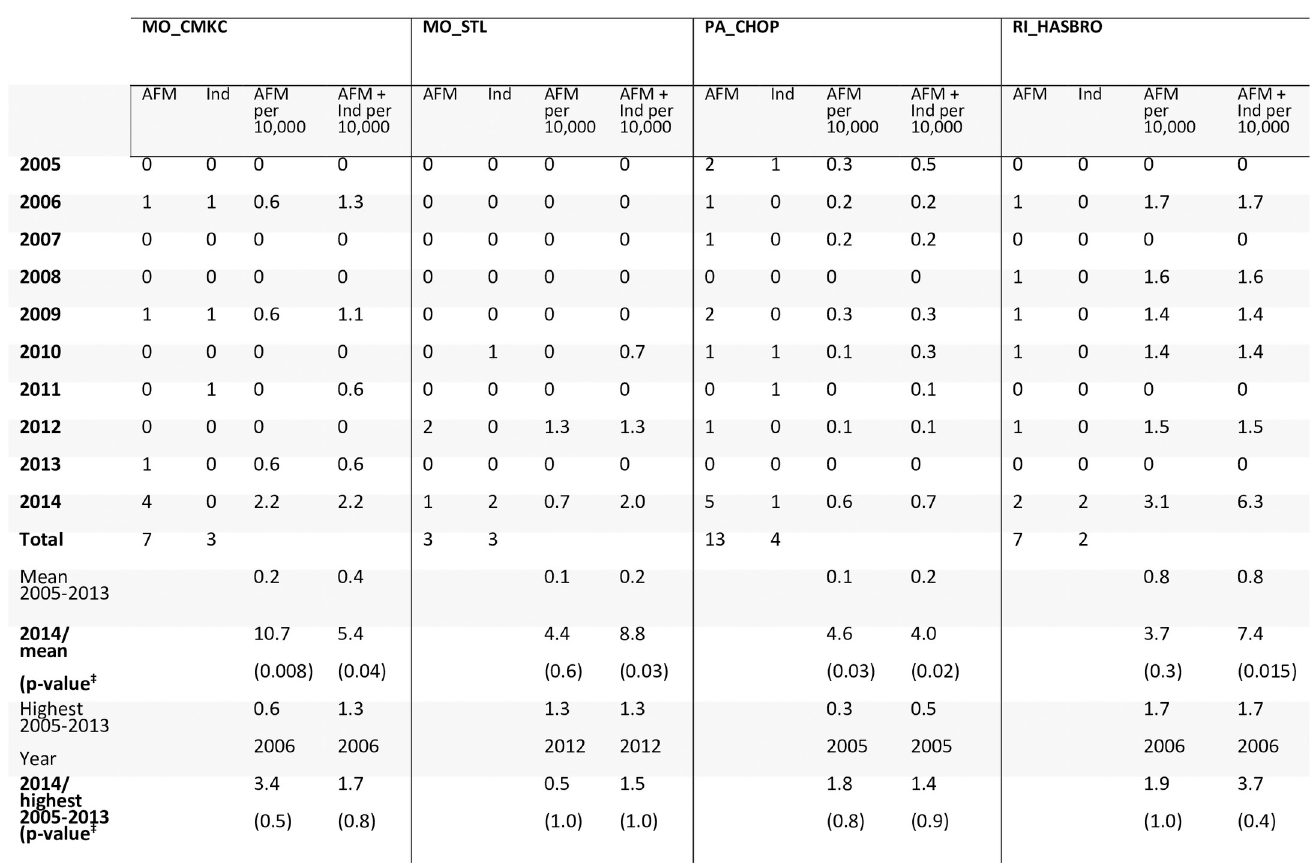
Fig 1. Number of AFM and indeterminate cases by calendar year and site among persons aged � 18 years, and cases per 10,000 pediatric hospitalizations.